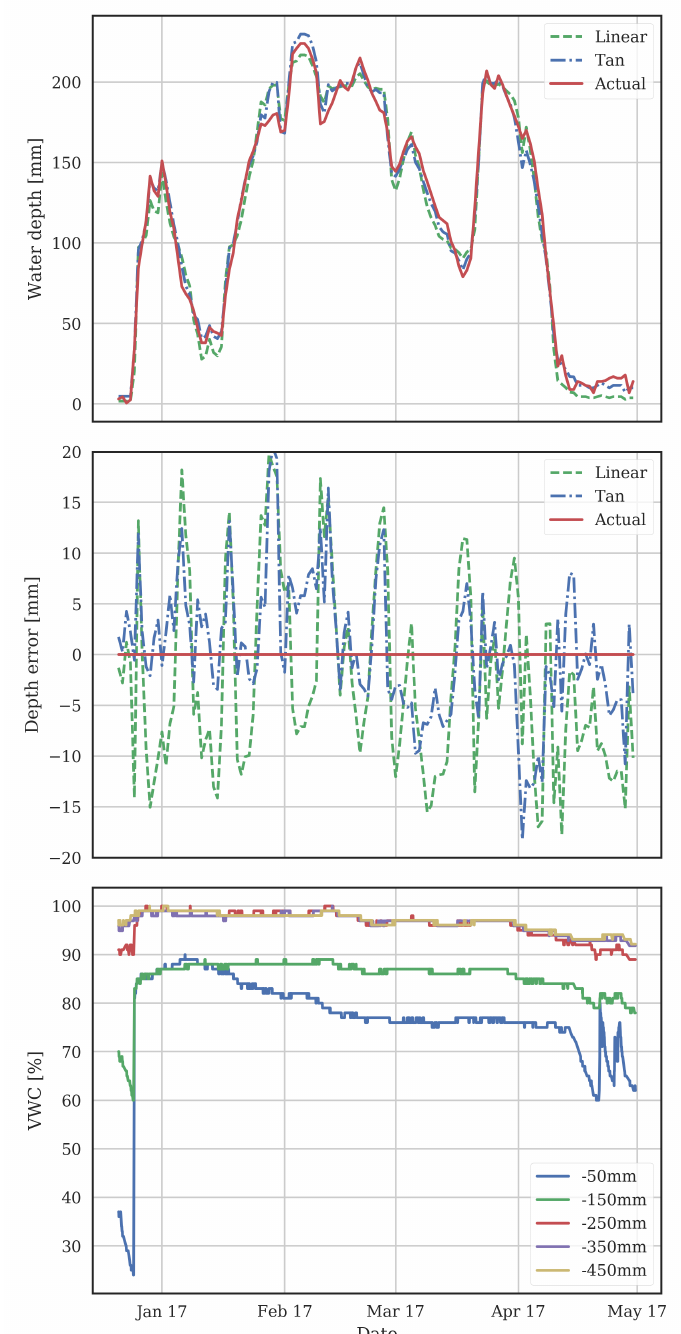
Figure 6. Measurements from a rice field over a growing season. The top graph shows the water depth from the ultrasonic sensor and from the MCP probe using the linear and tangent models. The middle graph shows the difference between the ultrasonic depth and depths calculated from the MCP readings. The bottom graph shows the soil